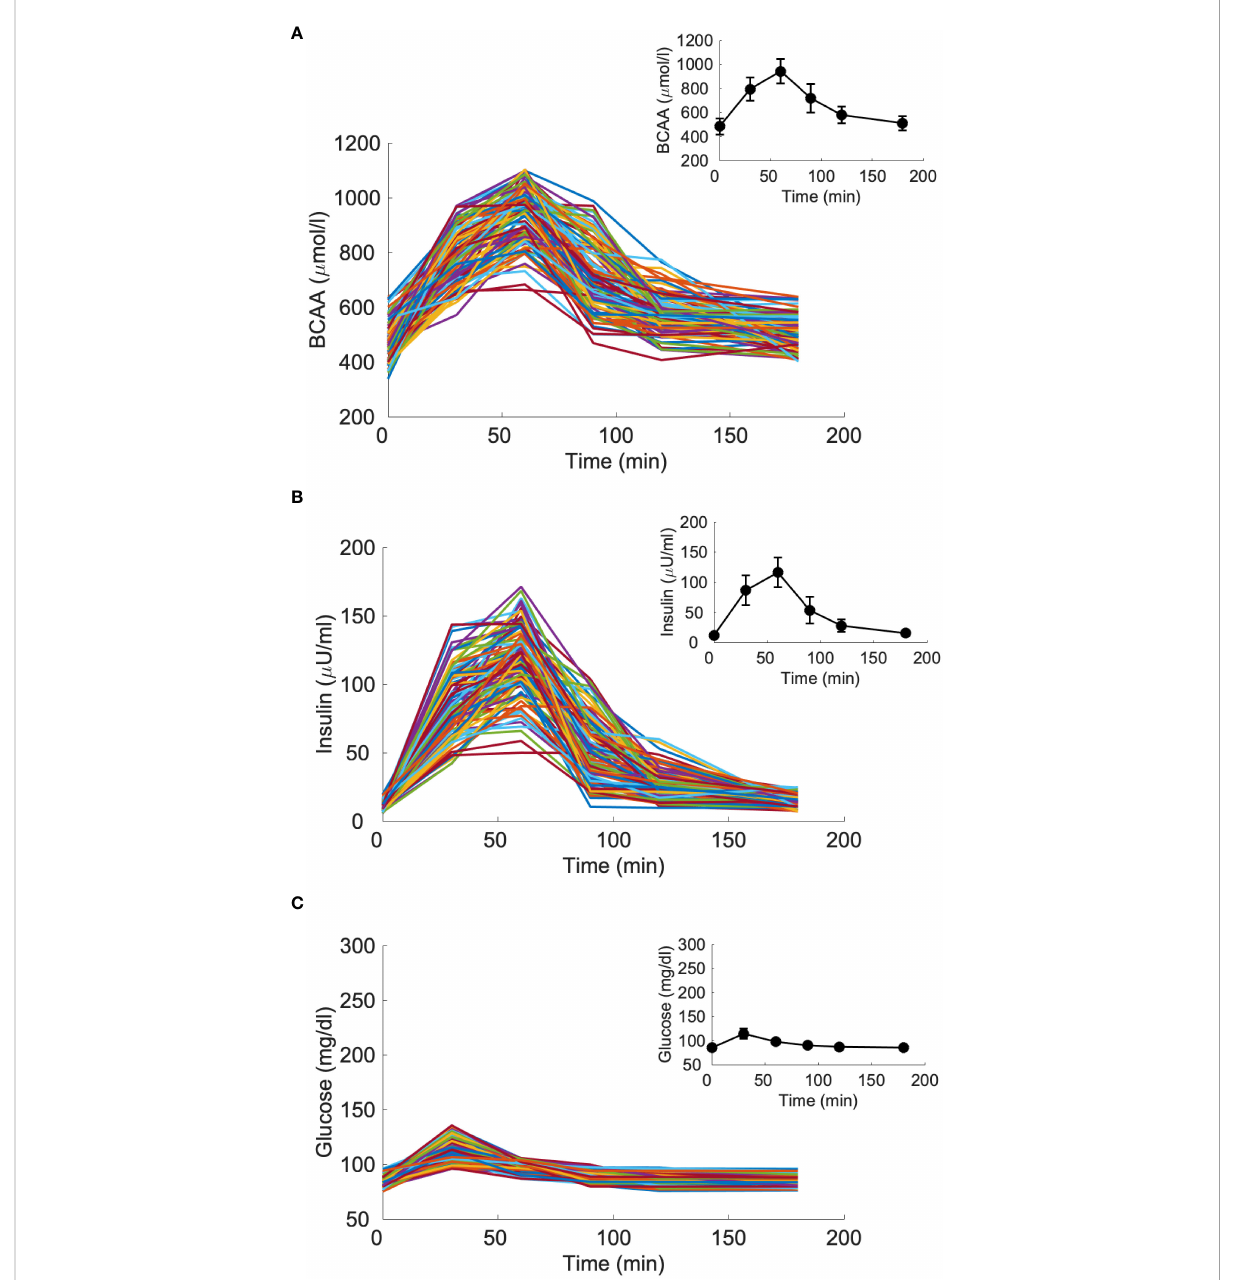
FIGURE 5 Branched-chain amino acids (BCAA), insulin and glucose curves for the virtual population composed by 100 glucose-tolerant individuals (CNT, “ spaghetti plot ” in panels A , B , C ); BCAA, insulin and glucose mean (± SD) computed over the 100 curves (black lines in the inset